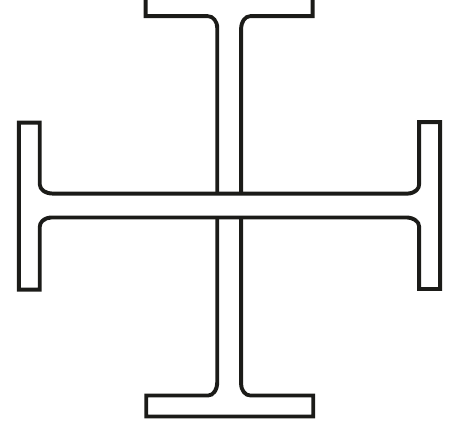
Figure 1: Typical flanged cruciform.